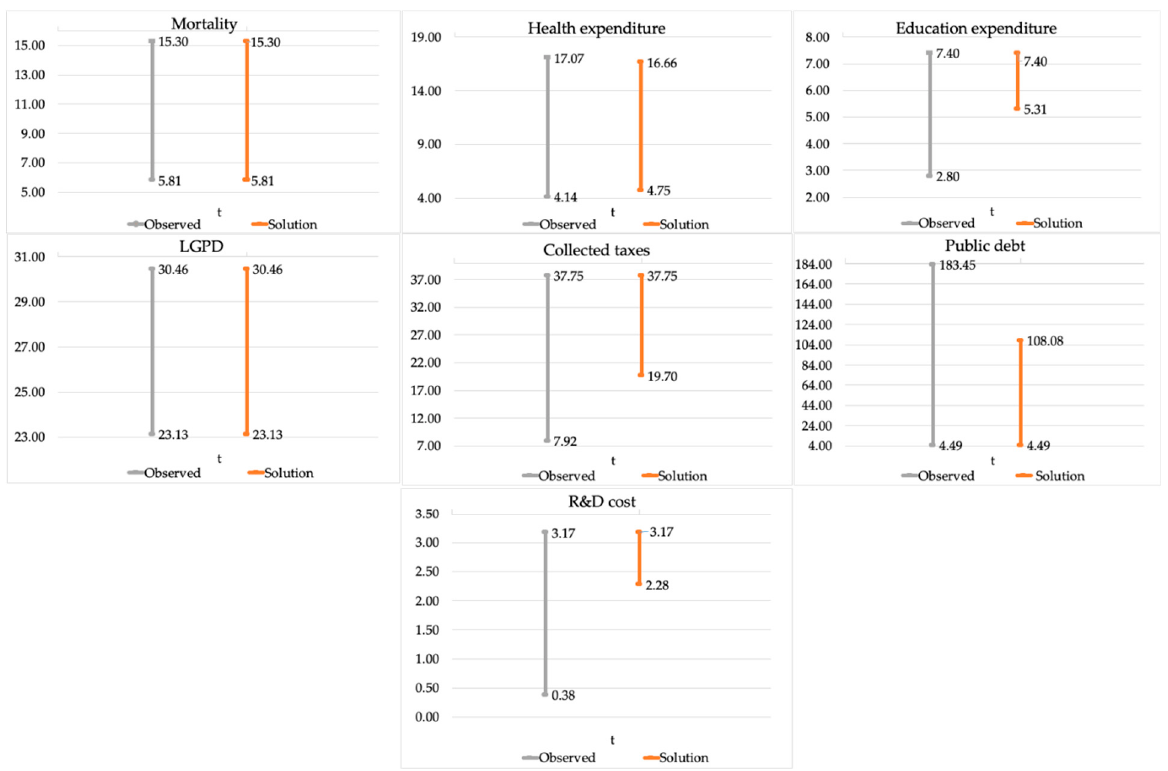
Figure 5. Comparison of ε -efficient solution variation ranges and observed values from the dataset.